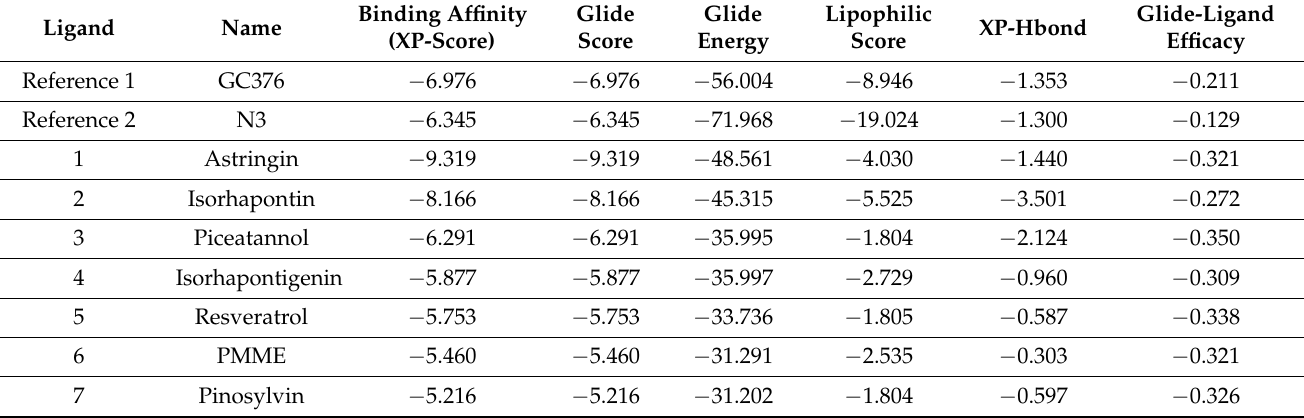
Table 2. Molecular docking results and interaction details for the reference and stilbene compounds.